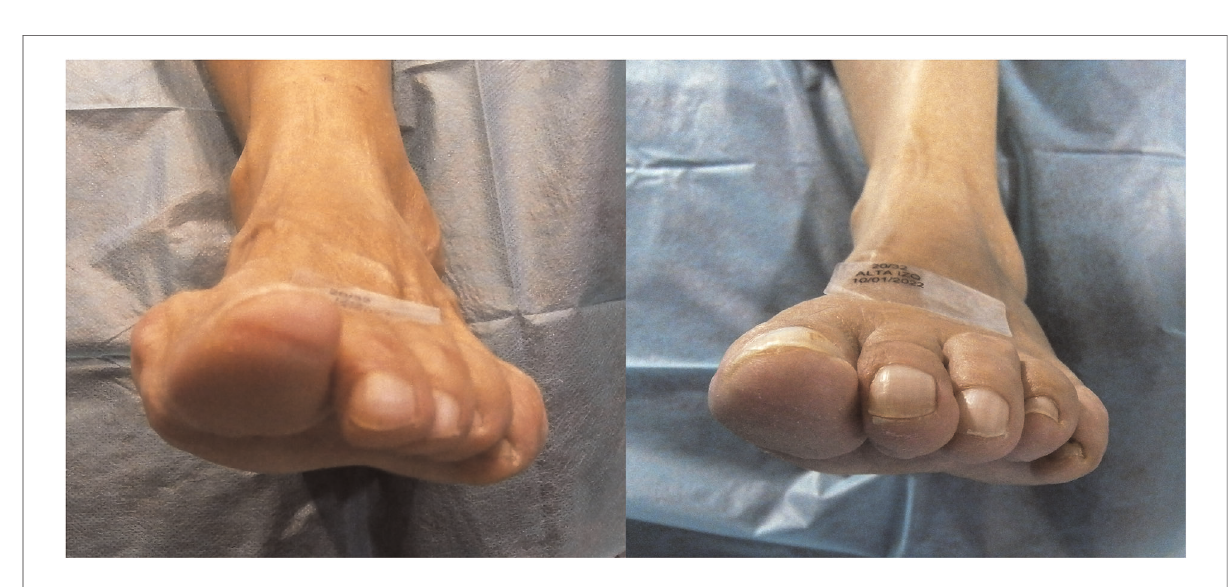
FIGURE 4 Frontal pre and postoperative images of the left fourth toe. Note the changing position of the